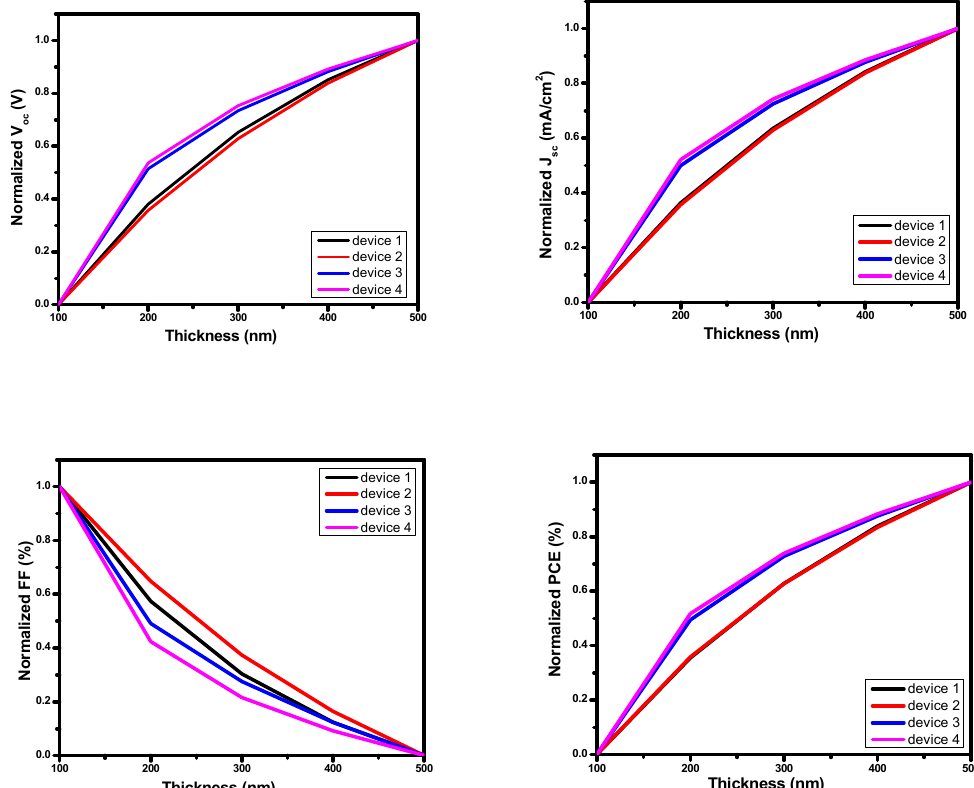
Figure 10. Comparing the values of V oc , J sc , Fill factor and PCE for varying ETL thickness.